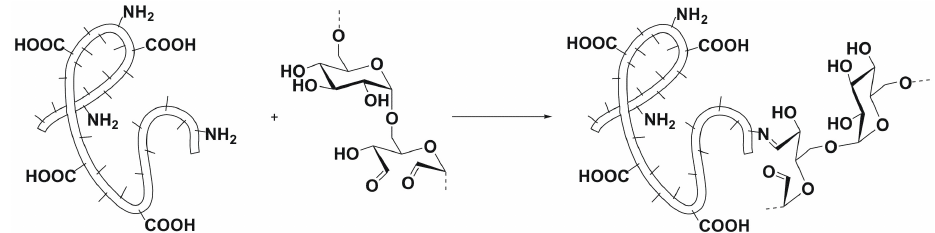
Figure 1. Schematic illustration of the cross-linking reaction between Dex-Ox and